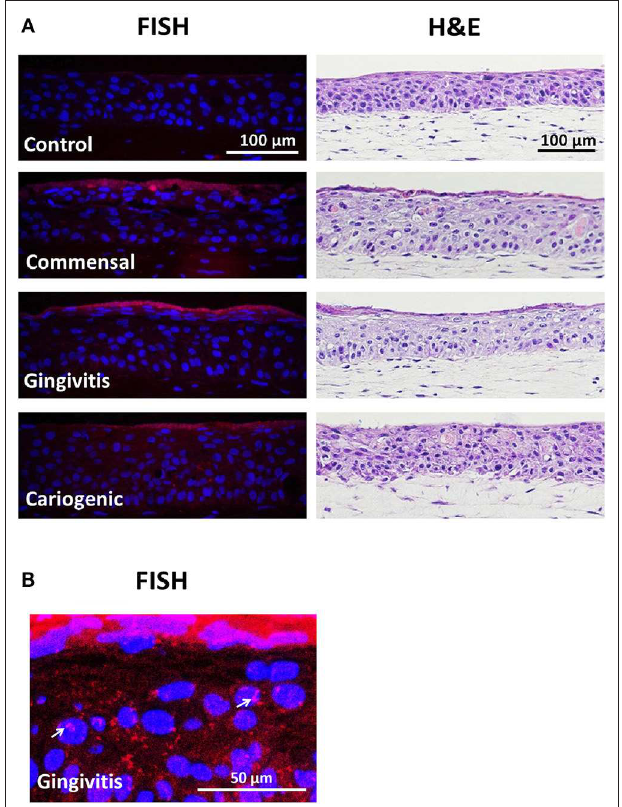
FIGURE 2 | Biofilm exposure does not detrimentally influence RHG histology. (A) Biofilms were topically exposed to RHG for 24h. Paraffin embedded tissue sections were used to visualize biofilm by fluorescence in situ hybridization (FISH, left panel) and RHG histology by hematoxylin and eosin staining (H&E, right panel). FISH shows a dense layer of bacterial rRNA (red) on top of the biofilm-exposed RHG, while no red was found in the unexposed RHG. The nuclei of epithelial keratinocytes in RHG are stained with DAPI (blue). H&E shows a stratified gingiva epithelium on a fibroblast populated collagen hydrogel. Data represent three independent experiments, each with an intra-experiment duplicate. (B) Enlarged FISH staining shows bacteria invading into RHG epithelium after gingivitis biofilm exposure (white